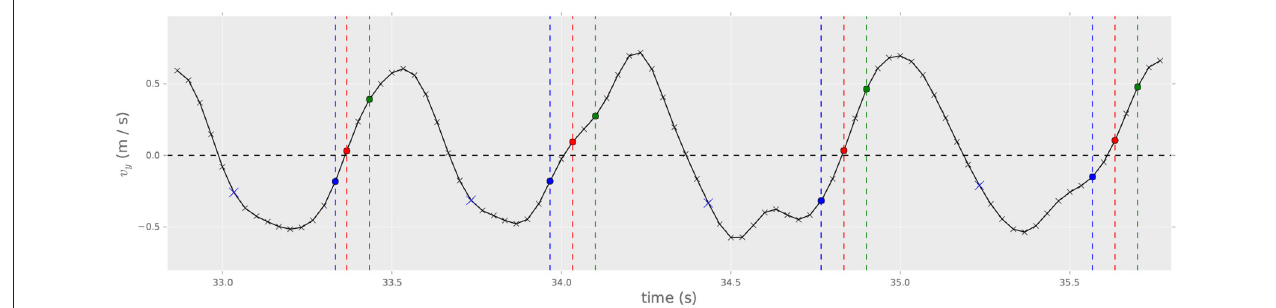
FIGURE 1 | Beat triggering from v y with BASELINE (red circles) and TRAINED systems (green circles, n ant = − 2; blue circles, n ant = 2). Samples highlighted as blue crosses set the v trigger values for n ant = 2 in the TRAINED system.